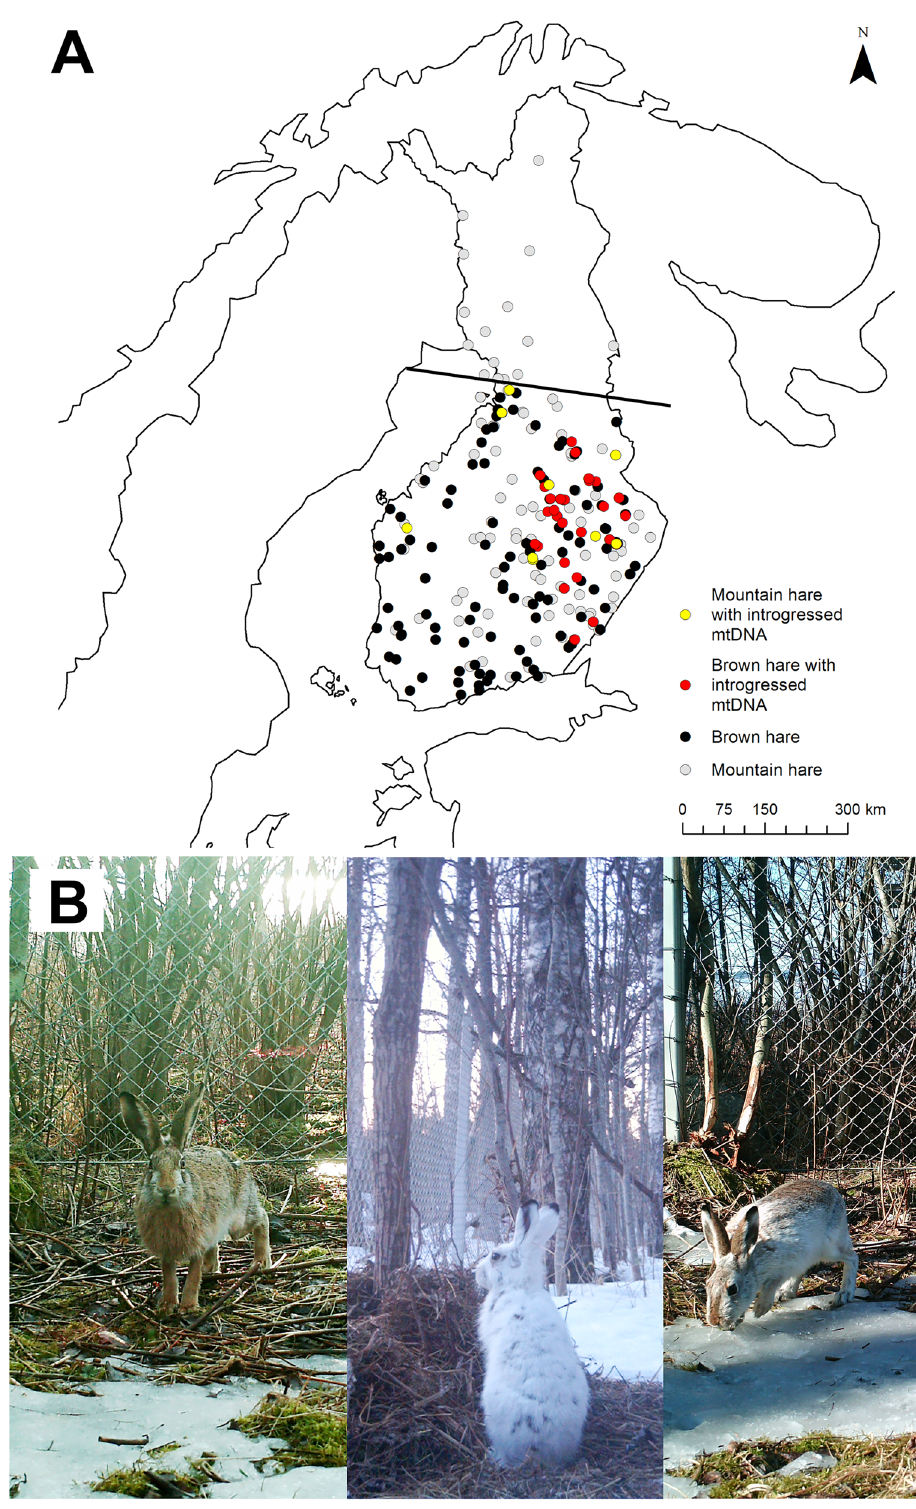
Figure 1. Hybridization among Finnish hares. ( A ) Distribution of samples used in the study. The level of mtDNA introgression roughly correlates with the expansion front of the brown hare 6 . The allopatric mountain hare samples north from the line were assumed as “purebred” for the purpose of the TSP analyses. Both species coexist south of the line, although mountain hare abundance decreases notably towards the south-west. ( B ) Excerpts from game camera images from the same location in Joensuu, Finland in April 2014. Typical brown hare in the left and mountain hare in the middle. Individual on the right was later captured and confirmed as a first-generation hybrid (sample 843), having brown hare mtDNA, but being heterozygous for the tested nuclear loci (Table S1). The individual was originally assigned as a brown hare based on morphology and mtDNA